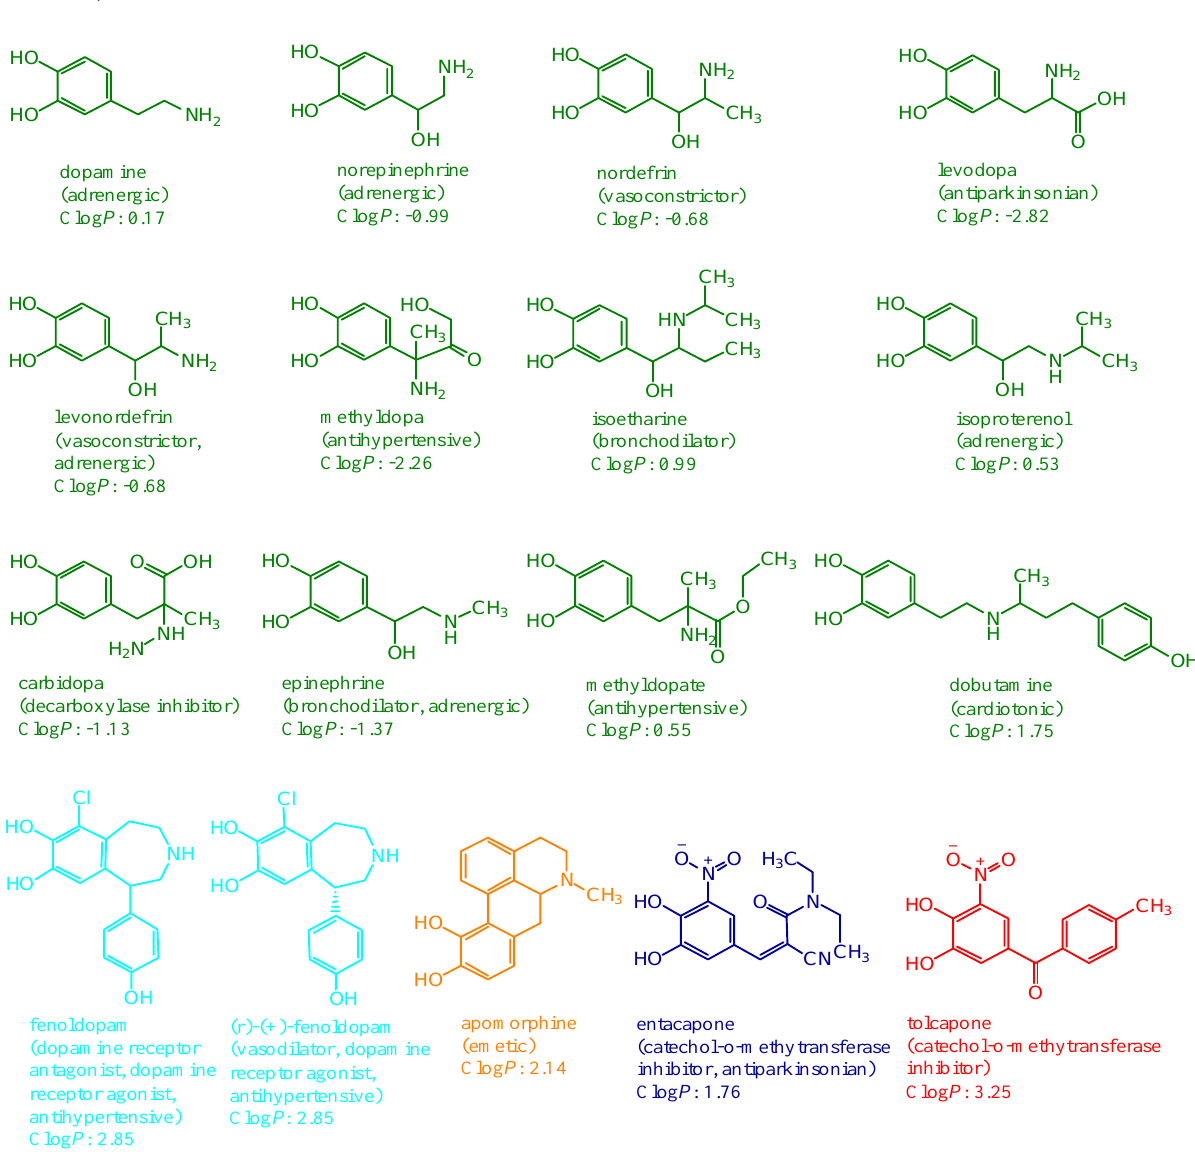
Figure 1. Structures, pharmacological effects and Clog P s of currently FDA-prescribed catecholic drugs. According to the substitutent patterns, these molecules are classified into 5 types (type I , in green; type II , in cyan; type III , in orange; type IV , in blue; type V , in